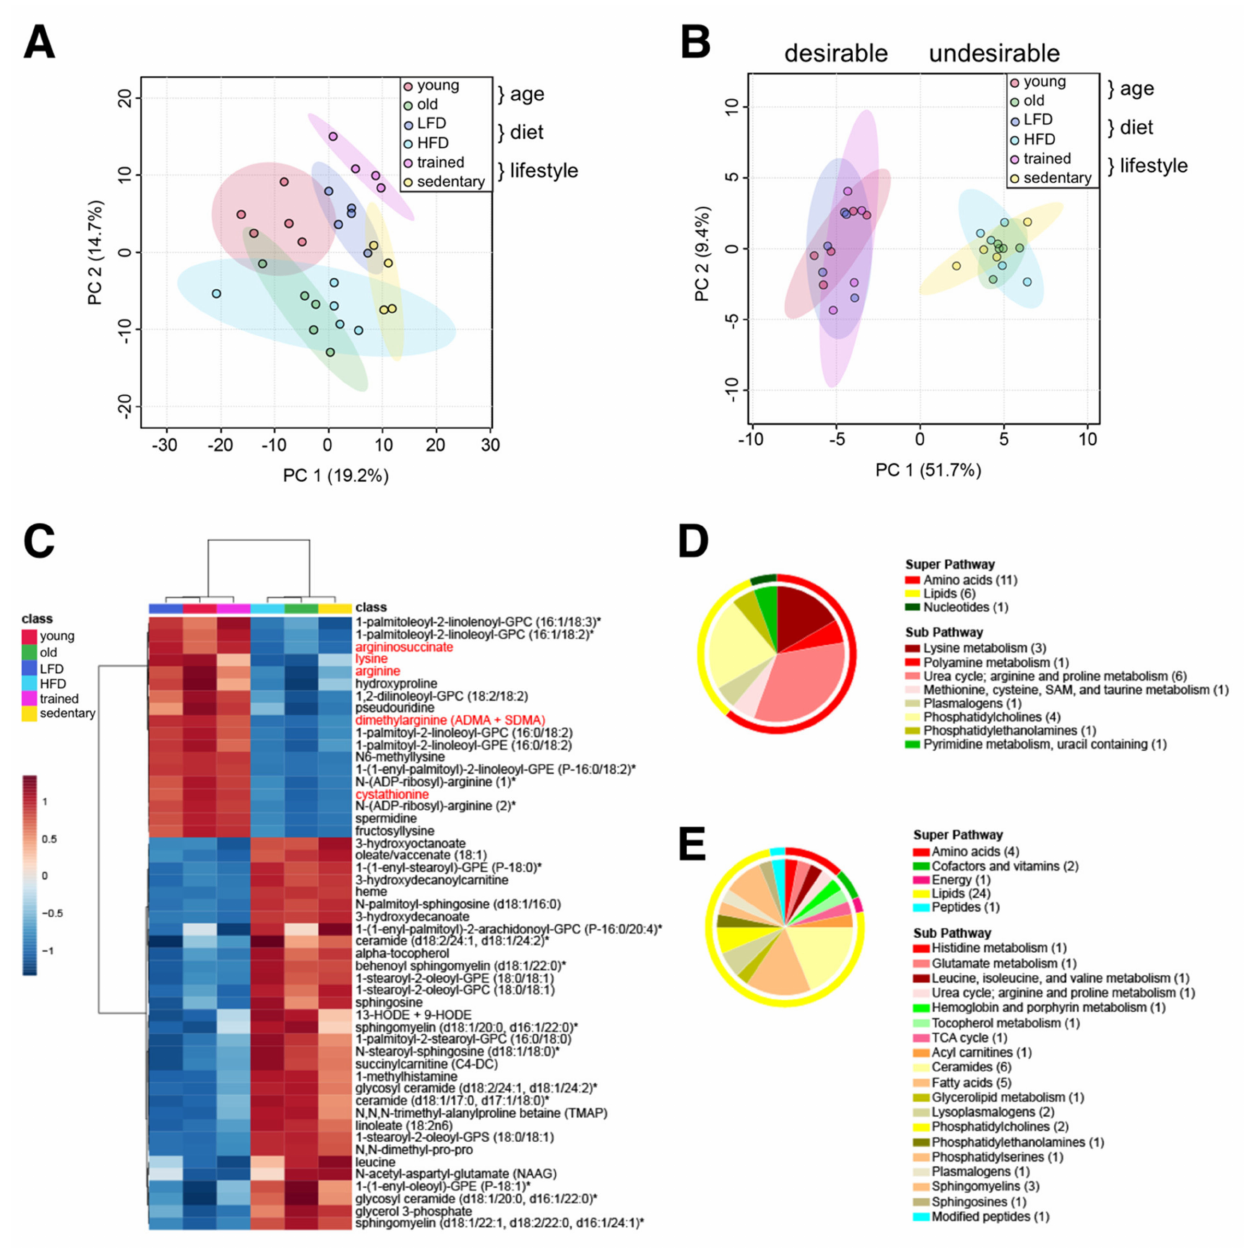
Figure 5. Common muscle metabolite signature distinguishes ‘desirable’ from ‘undesirable’ metabolic states. ( A ) Principal component analysis of all 427 metabolites in all three data sets. ( B ) Principal component analysis of 50 common metabolites identified by meta-analysis. ( C ) Heatmap of 50 common metabolites identified by meta-analysis. Group averages are presented. Metabolites labeled with an asterisk have not been confirmed with a standard, but we are confident of their identity. Metabolites localized in mitochondria are labelled red. ( D , E ) Classification of metabolites decreased ( D ) or increased in the ‘undesirable’ metabolic state ( E ) according to the super pathway (outer circle) and the sub pathway (inner circle). The number of metabolites per class is given in